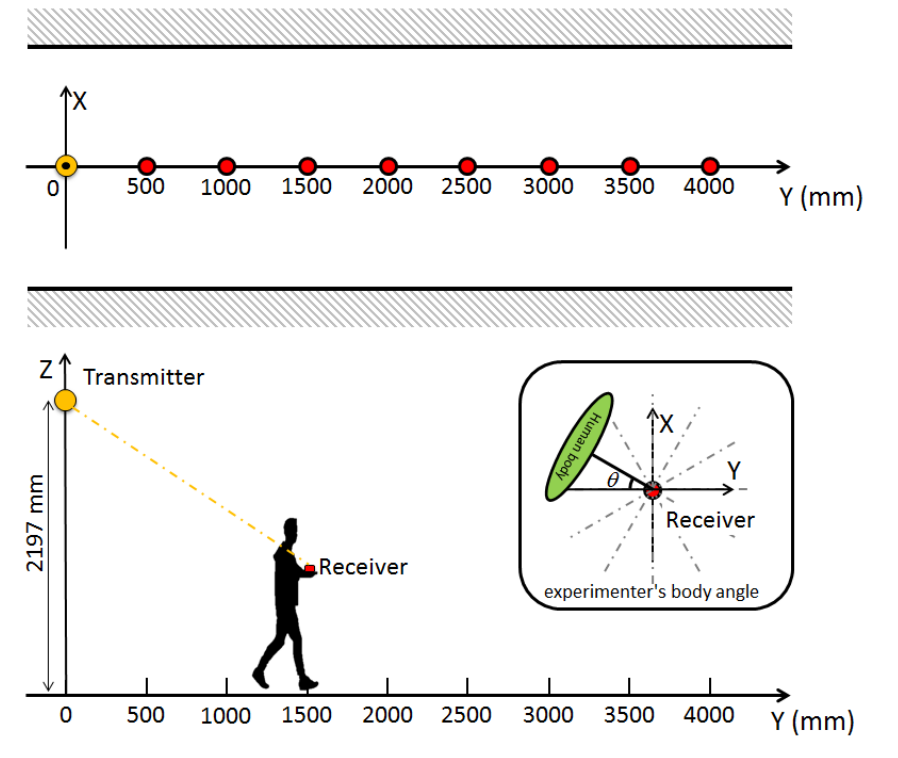
Figure 17. Experimental setup for human body interference.